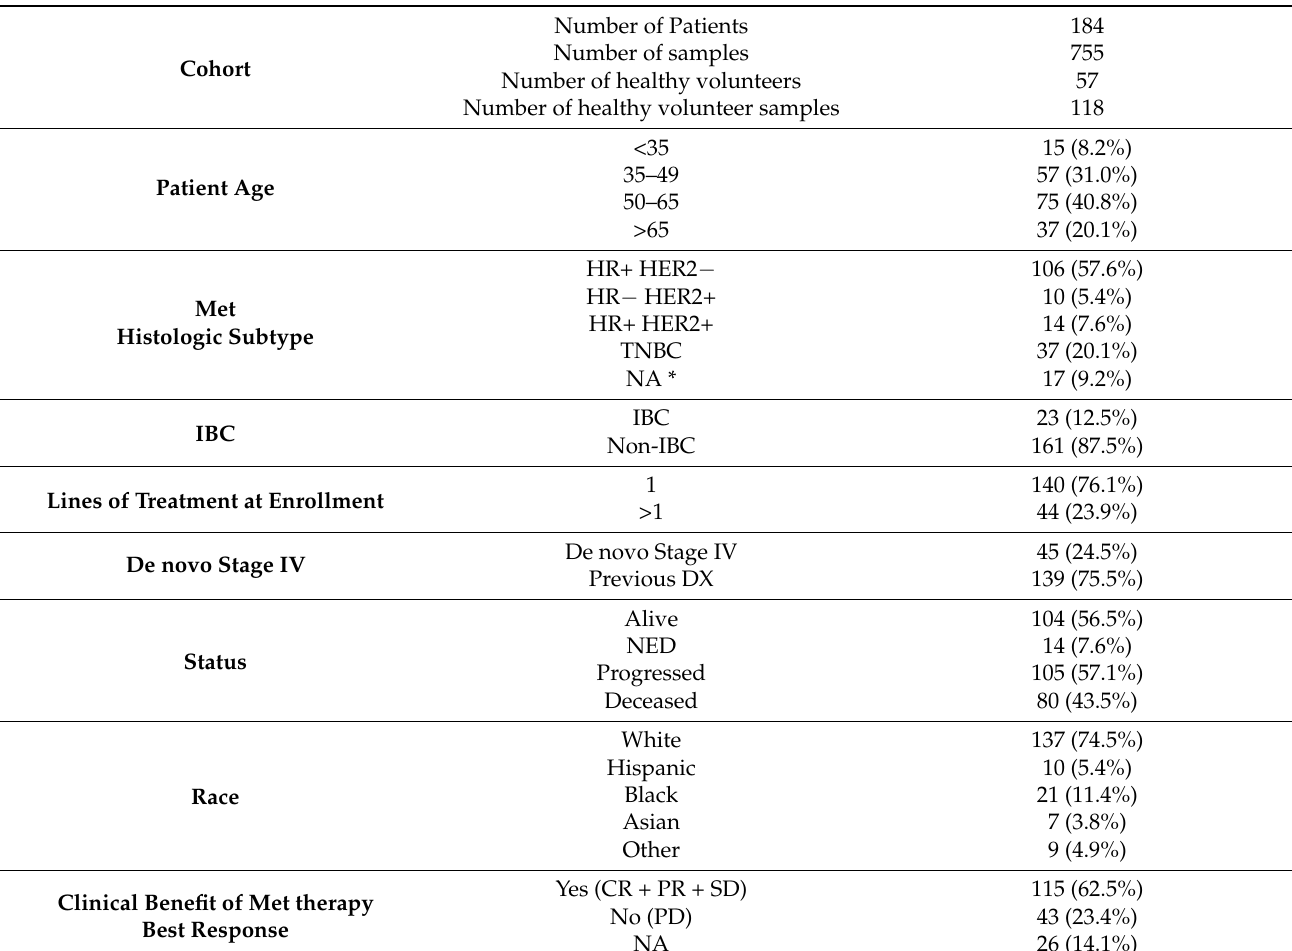
Table 1. Summary of demographics and clinical characteristics of patients with MBC that participated in the